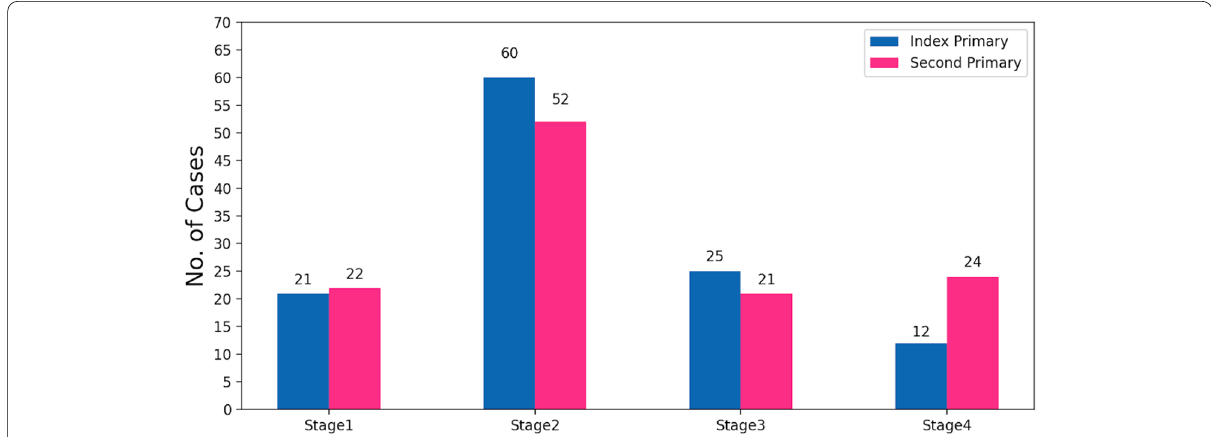
Fig. 4 Graph representing the clinical TNM Staging of first and second primary